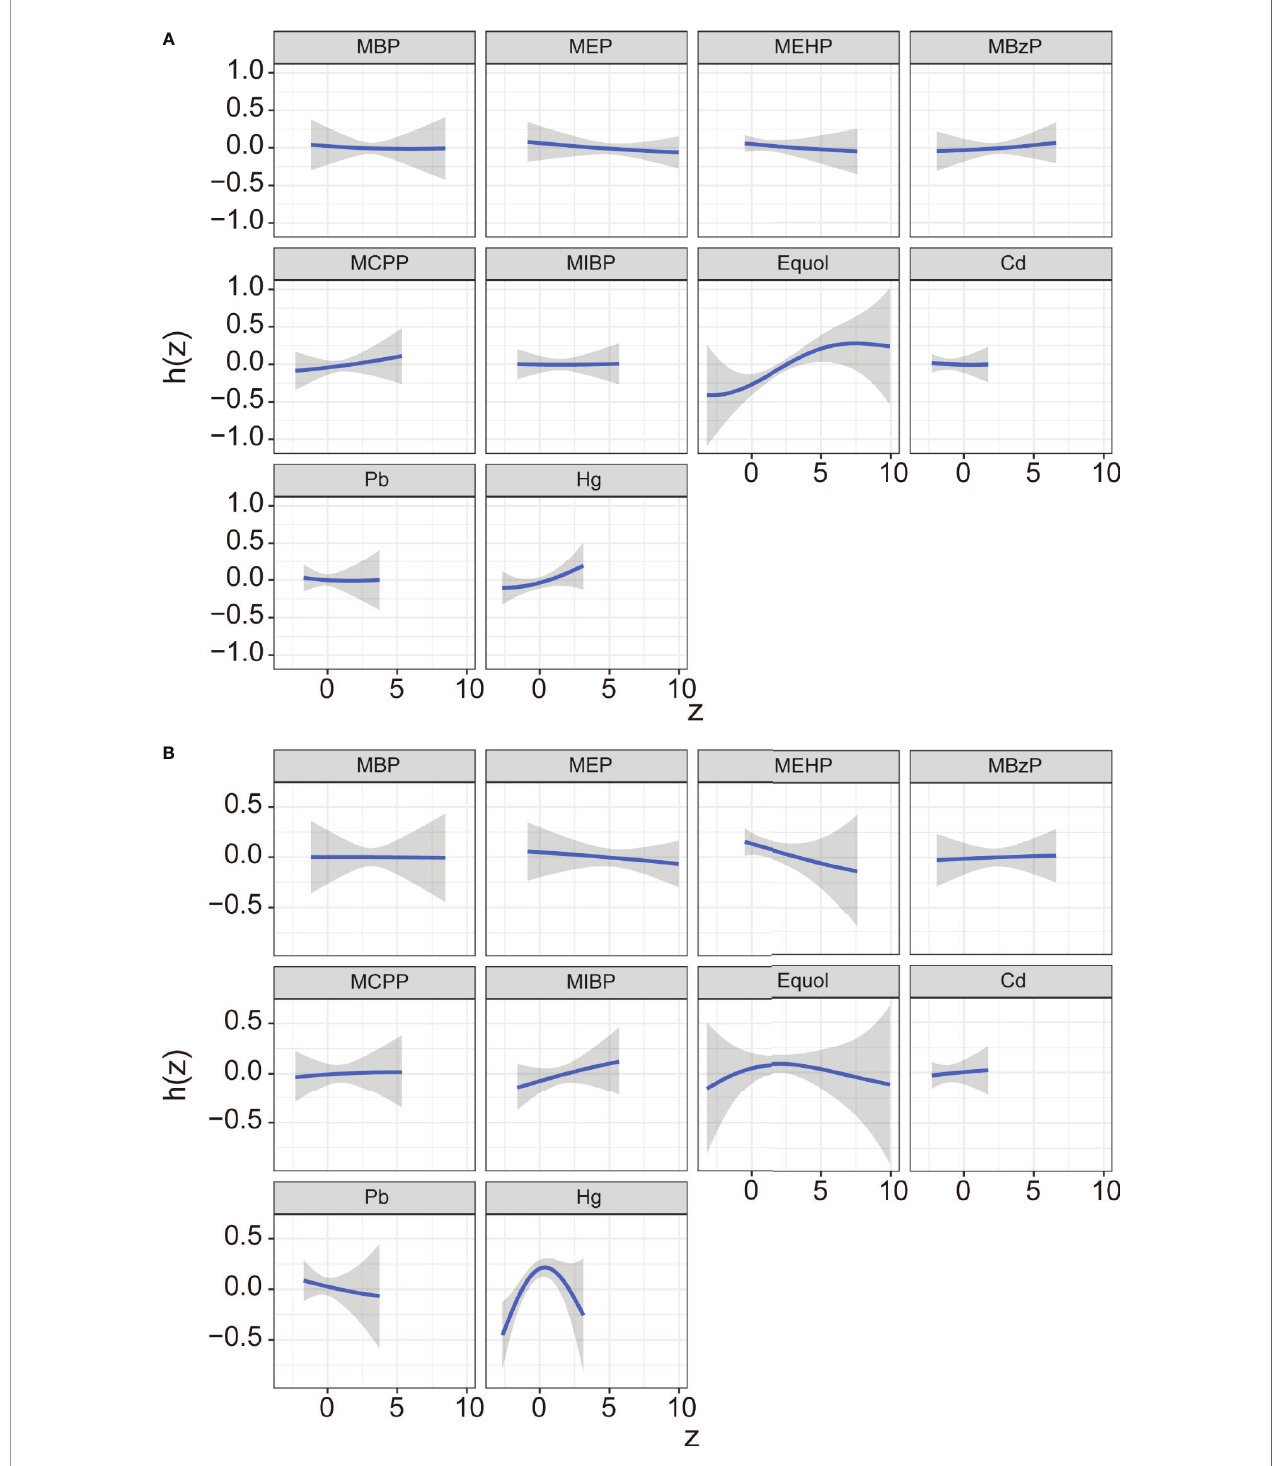
FIGURE 4 | Exposure-response function (95% CI) between selected chemical exposure and uterine leiomyomata (A) or and endometriosis (B) with fi xing all the other chemicals at their median level. Models were adjusted for age, ethnicity, BMI group, ovary removal, female hormone usage, pregnant status, menopause status, and log-transformed urinary creatinine